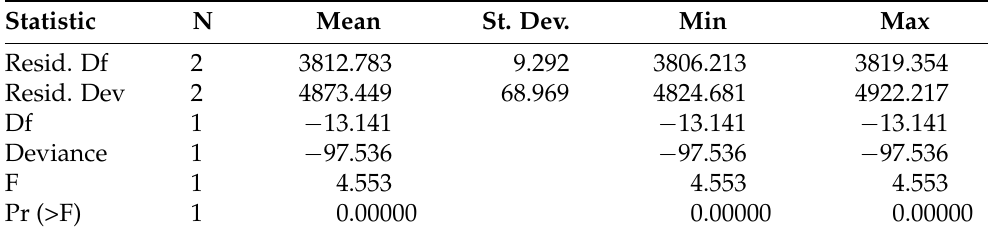
Table 7. Statistical test result and summary statistics for the GAM modelling of claim amounts, with and without designed rating territories. Note that the test is based on Deviance, which is a goodness-of-fit statistic for the model, calculated based on the log likelihood-ratio; Pr (>F) is the p -value of the test. “Resid. Df” means Residual Degree of freedom; “Resid. Dev” means Residual Standard Deviation; “Df” means Degree of